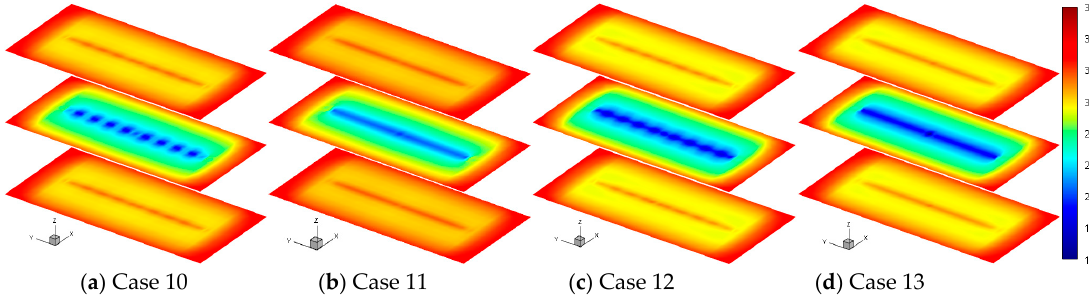
Figure 24. Comparison of σ xx distribution between different cases after 10 years, MPa. The profiles are shown in the top, middle and bottom layers, and the length in the z -direction is shown as 6.67 times the real size.